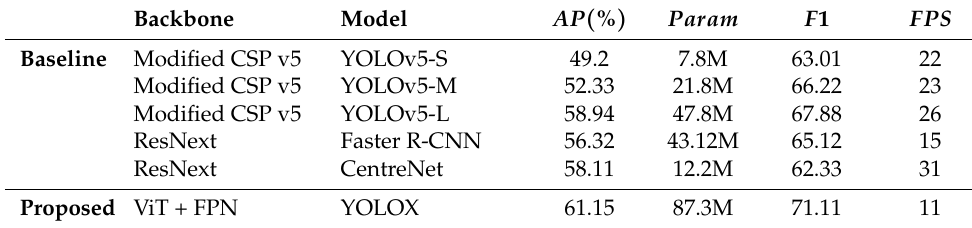
Table 1. Comparison of the average precision of different object classifiers on Road Asset test-corpus. We select all the models trained on 100 epochs for a fair